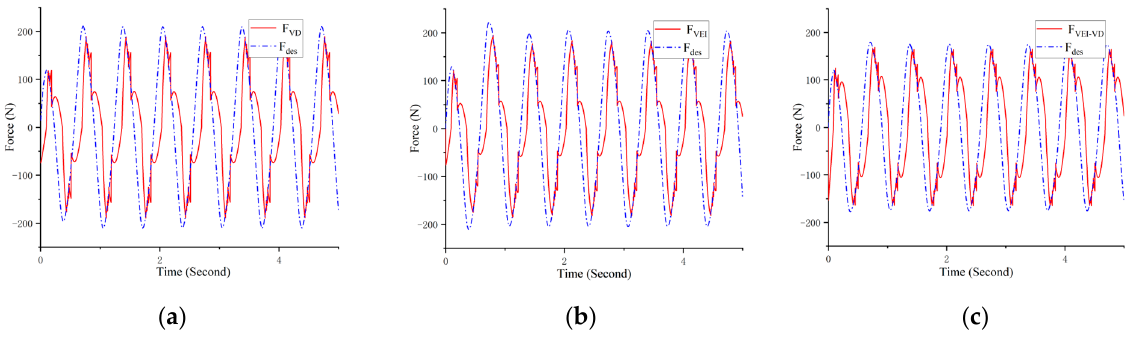
Figure 14. The performance of force tracking strategies: ( a ) The force tracking of the VD device; ( b ) The force tracking of the VEI device; ( c ) The force tracking of the VEI–VD device.